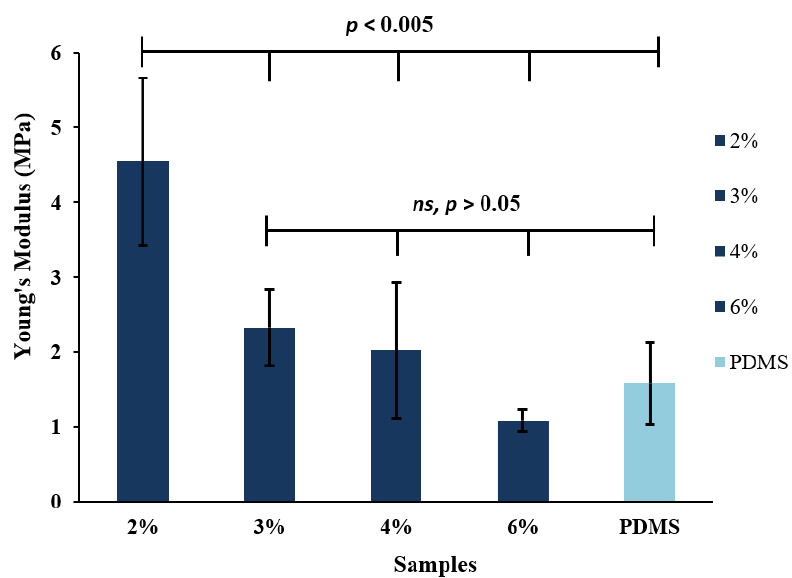
Figure 16. Tensile test of conductive hydrogel films and PDMS film. The data show a significant increase in Young’s Modulus as the percentage of PEDOT: PSS and glycerol decreased in the hy- drogel matrix. Denotes n = 5 samples for each